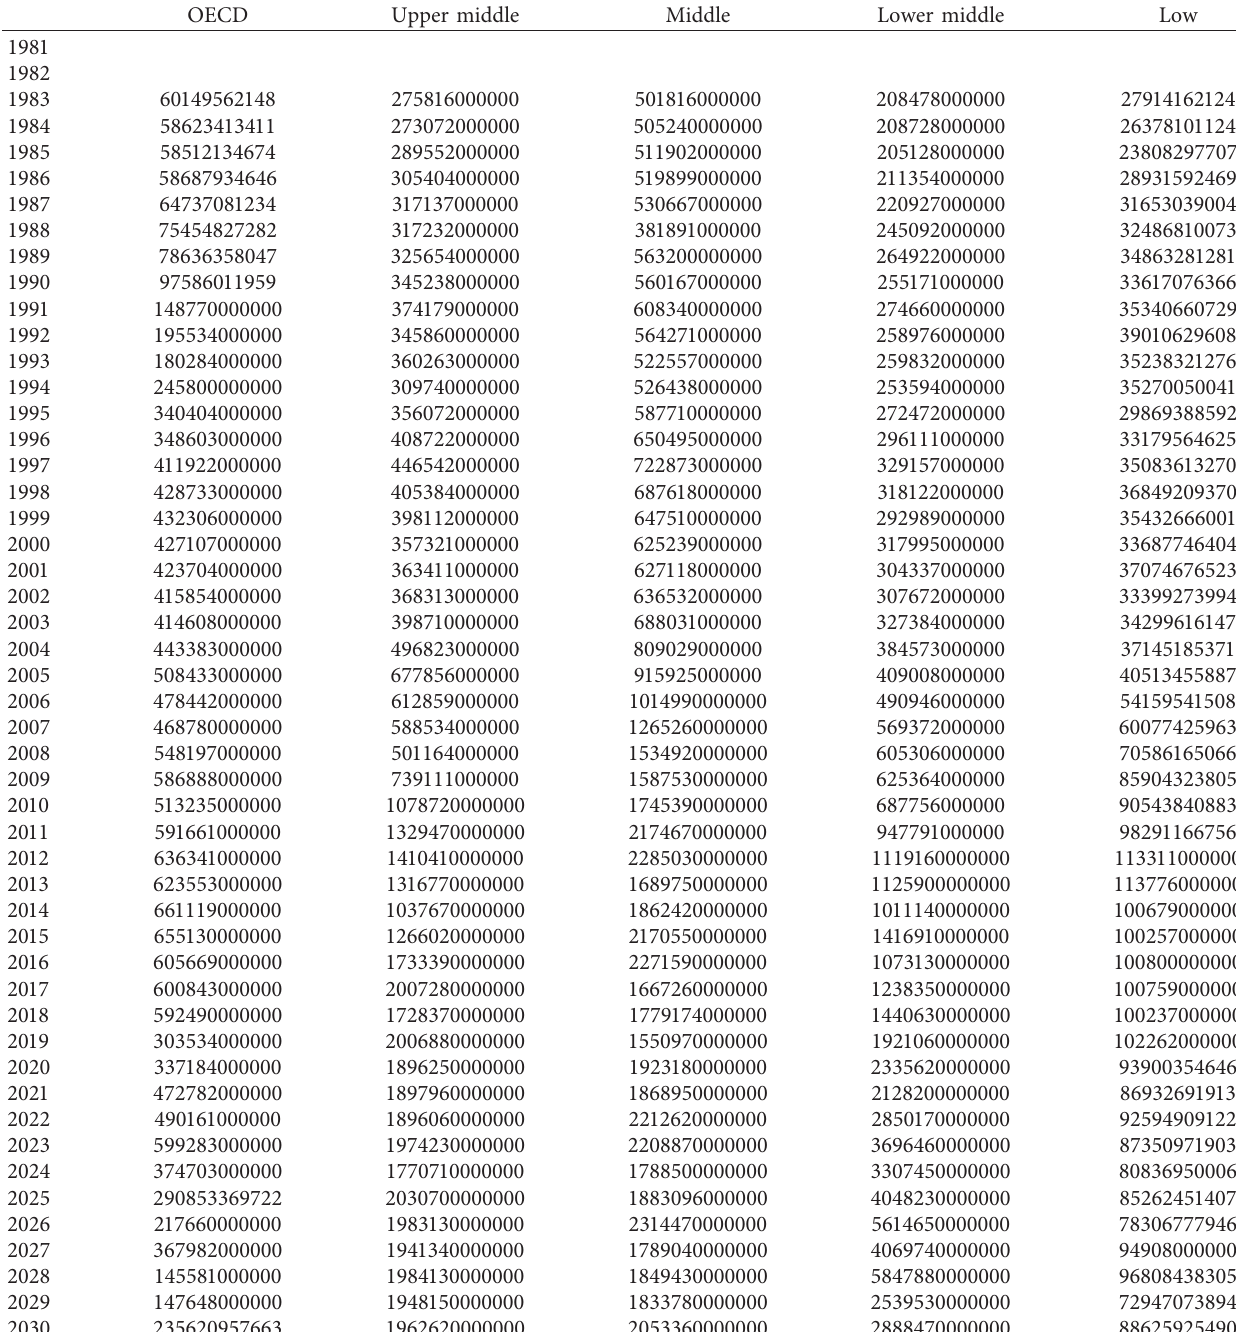
Table 7: Forecasted values of agriculture output in current USD under the ANN method. OECD Upper middle Middle Lower middle